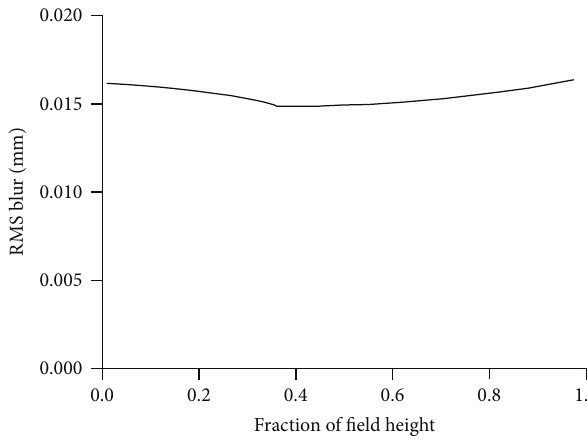
Figure 6: RMS spot diameter versus field height in mm for receiver.